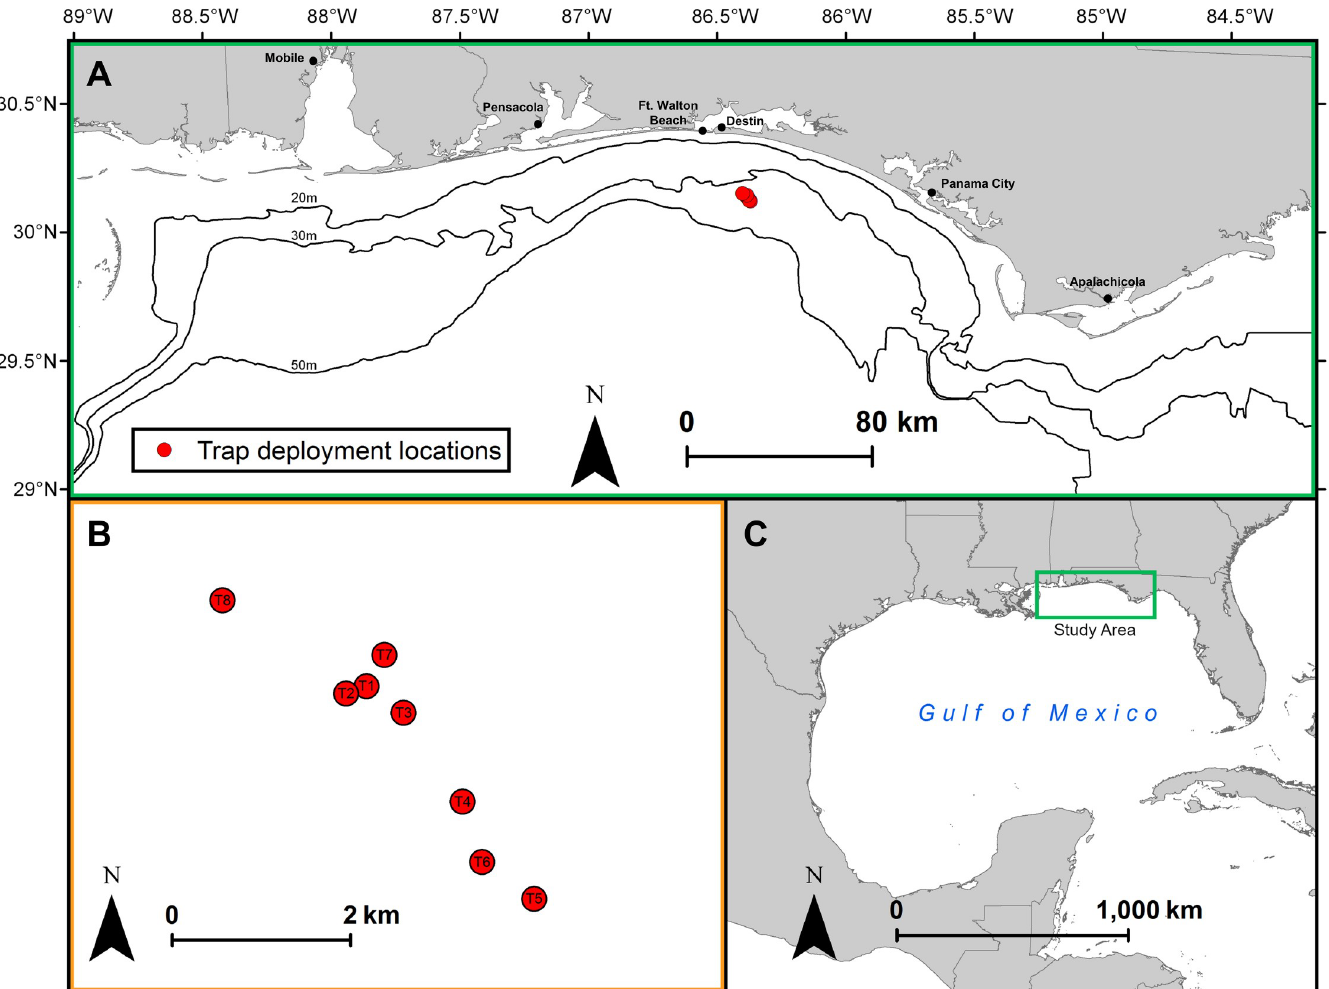
Fig 3. Study site locations for testing Gittings lionfish traps. A) Traps were deployed adjacent to artificial reefs approximately 30 km offshore NW Florida in depths of 33–37 m. The eight reef study sites were B) separated by > 300 m and C) located in the northern Gulf of